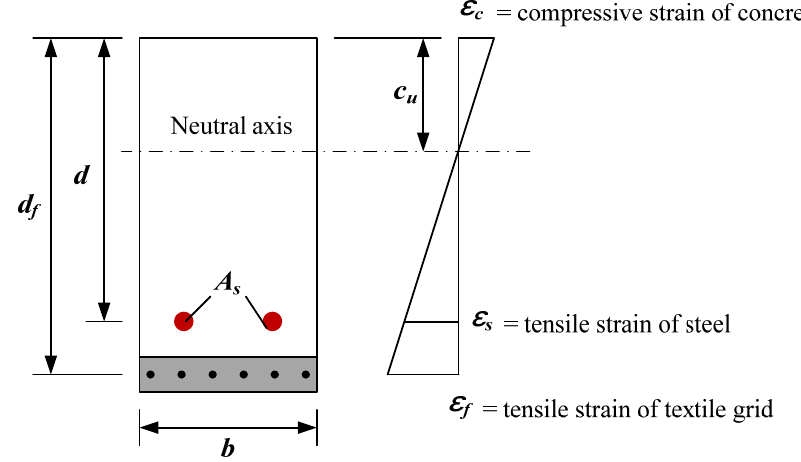
Figure 14. Internal strain distribution of a RC element strengthened by TRC system.